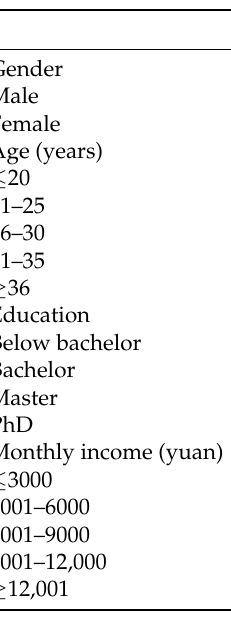
Table 1. Demographic